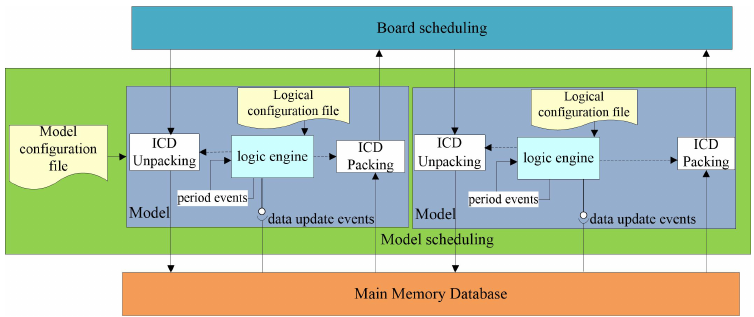
Figure 6. Model scheduling